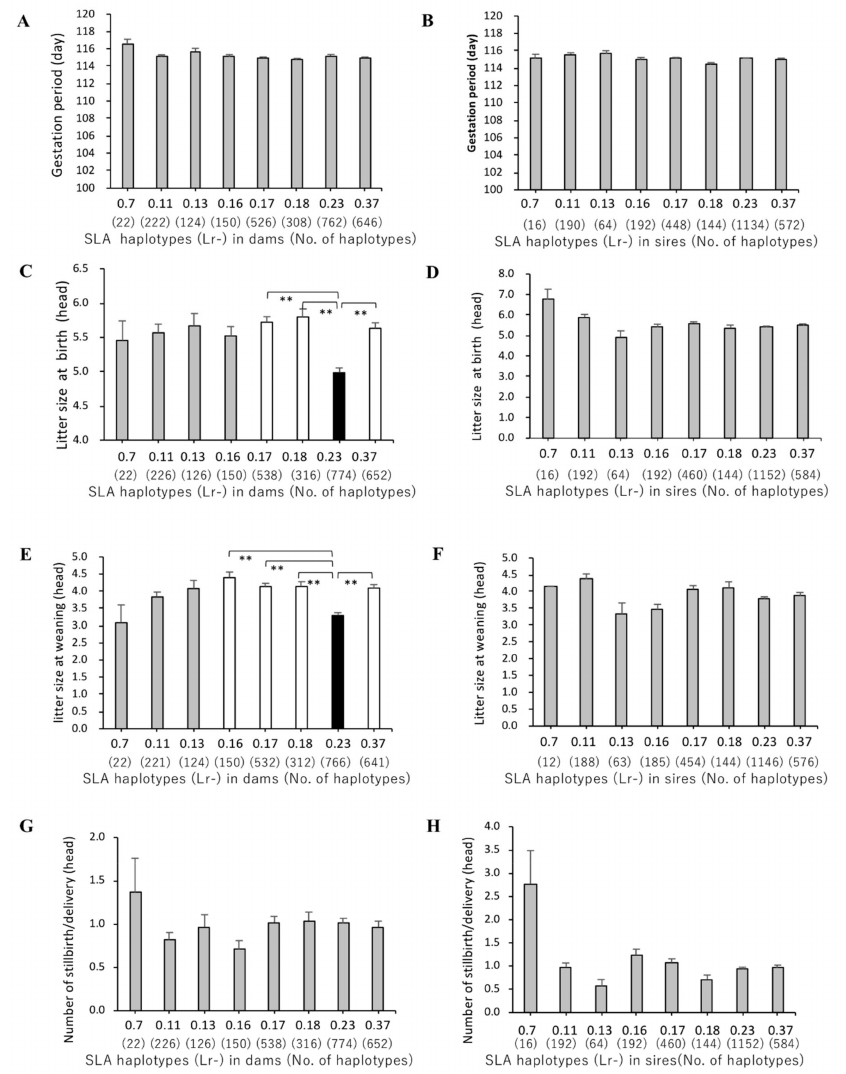
Figure 3. ComparisonofreproductiveperformancesofMMPswithdifferentSLAclassIIhaplotypes. X -axisfor A to H shows the homozygous or heterozygous SLA haplotypes and the number of matings for each haplotype in brackets (no. of haplotypes). Each bar along the X -axis indicates the mean values and whiskers (standard errors) of gestation periods in dams ( A ) and sire ( B ), litter sizes at birth in dams ( C ) and sires ( D ), litter sizes at weaning in dams ( E ) and sires ( F ), and the number of stillbirths / delivery in dams ( G ) and sires ( H ) shown along the Y -axis. Black and white bars represent lower and higher haplotypes, respectively, with mean values of each trait and significant differences among haplotypes. The gray bars represent mean values of haplotypes without any significant differences among the haplotypes. The probabilities of significant differences among haplotypes are indicated by single ( p < 0.05) and double ( p < 0.01)